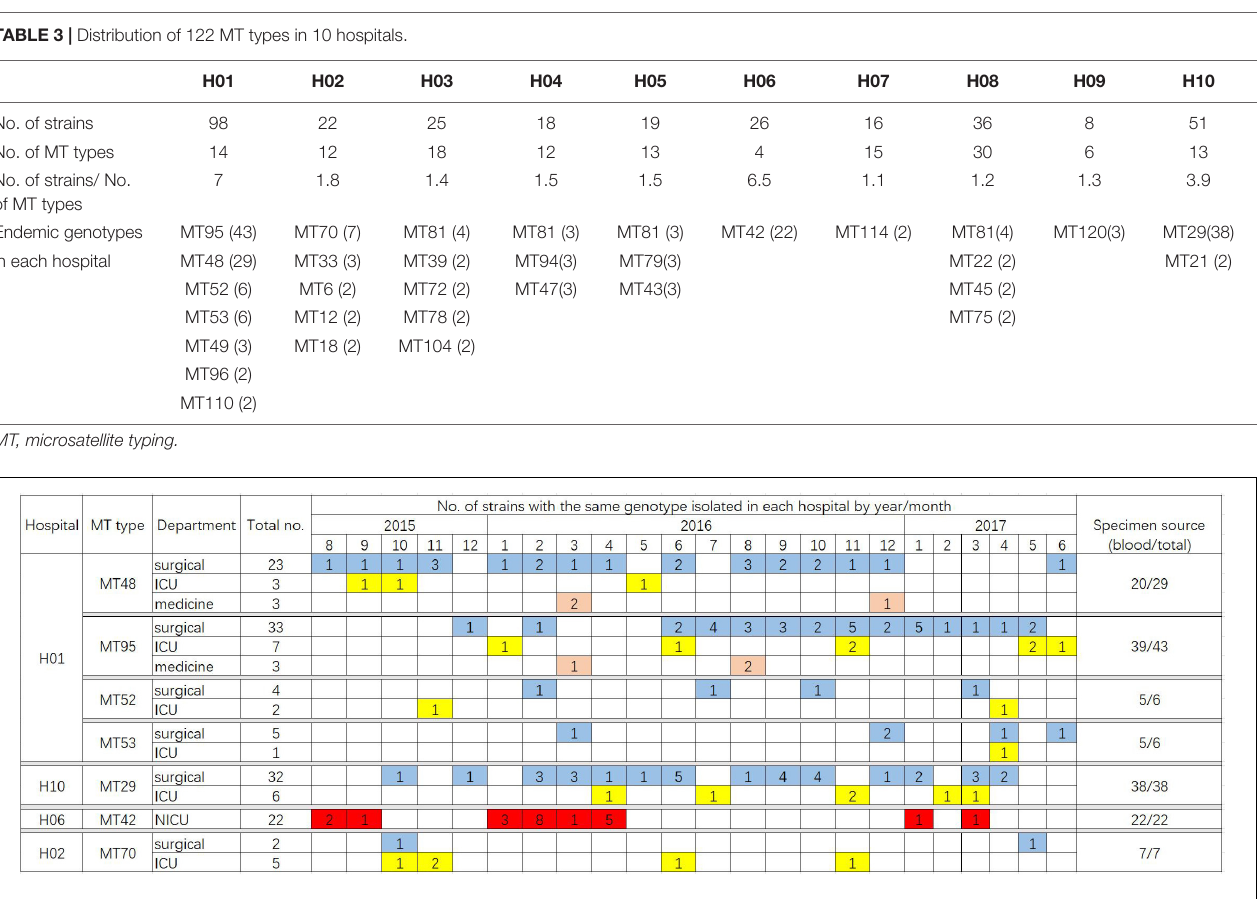
FIGURE 1 | Timeline of the ward distribution of MT types involved in clusters of in the hospitals, of which only clusters with more than five patients infected were shown in the figure. Different colors represent different departments. Blue, surgical department; yellow, ICU; orange, medicine department; red, NICU. In hospital H06, a total of 23 isolates were collected from NICU, of which 22 isolates belonged to the genotype MT42.